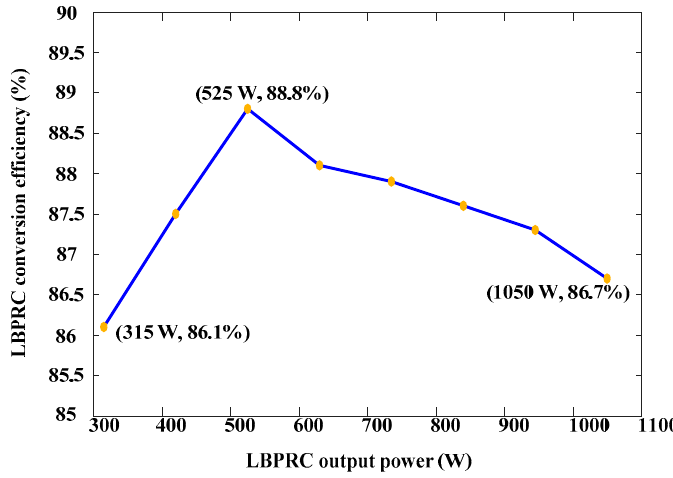
Figure 28. LBPRC conversion efficiency.